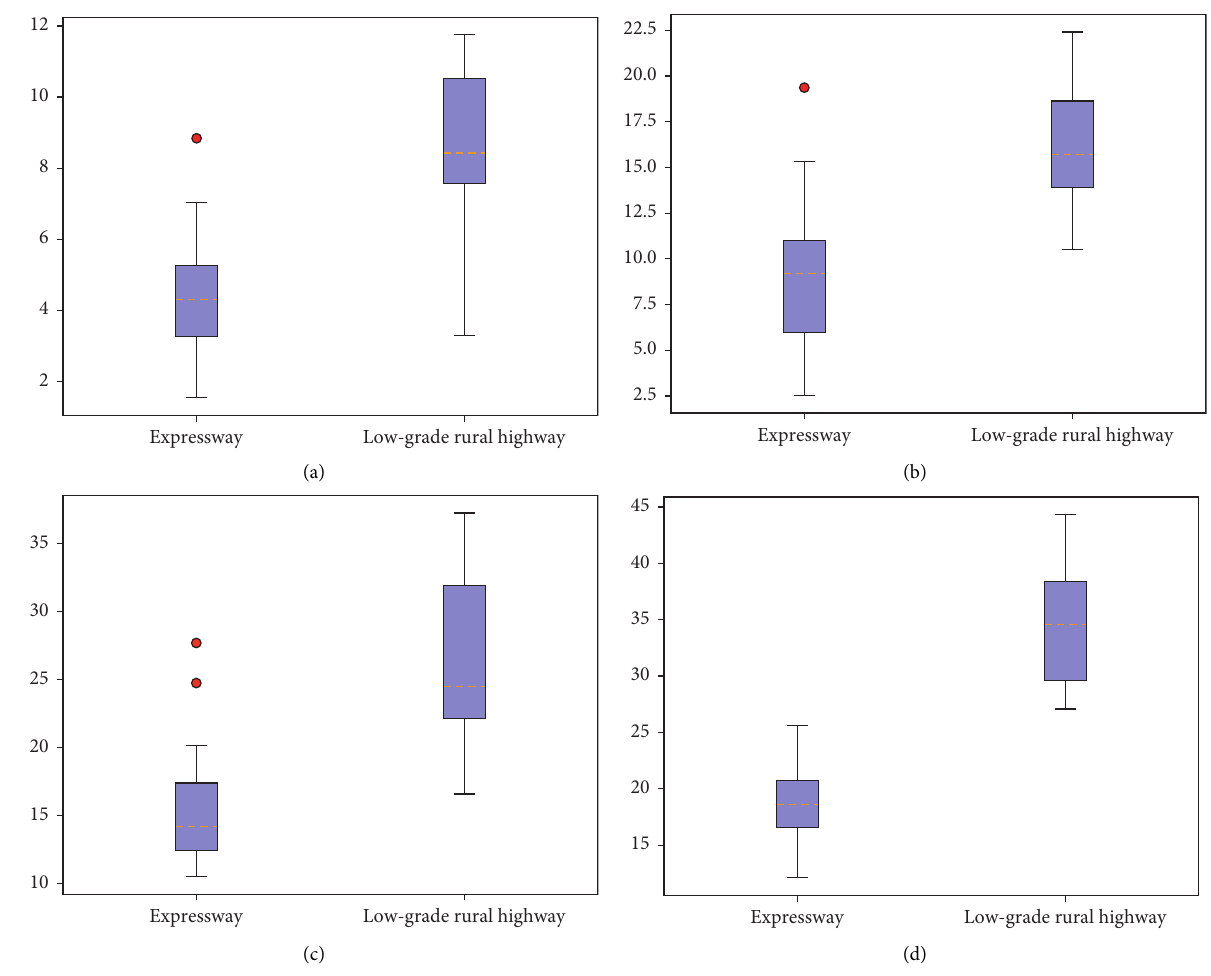
Figure 8: PERCLOS values for drivers at different times. (a) 15min. (b) 30 min. (c) 45min. (d)